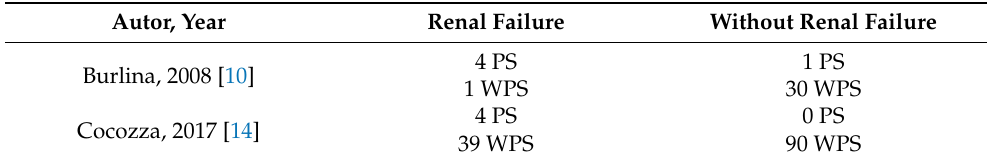
Table 3. Shows the frequency of renal failure in patients with Fabry Disease. PS—Pulvinar Sign and WPS—Without Pulvinar Sign [6,25].